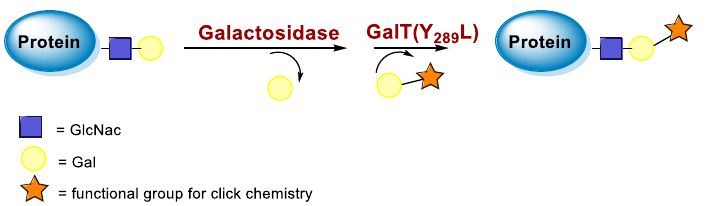
Figure 4. Protein derivatization with GalT(Y289L). A protein containing a carbohydrate chain with a terminal GlcNAc-Gal sequence (blue square and yellow circle for GlcNAc and Gal, respectively) is treated with a β-galactosidase to remove the terminal Gal, followed by the incorporation of a modified Gal sugar carrying a chemical handle using a mutant of β-1,4–galactosyltransferase, GalT (Y289L).